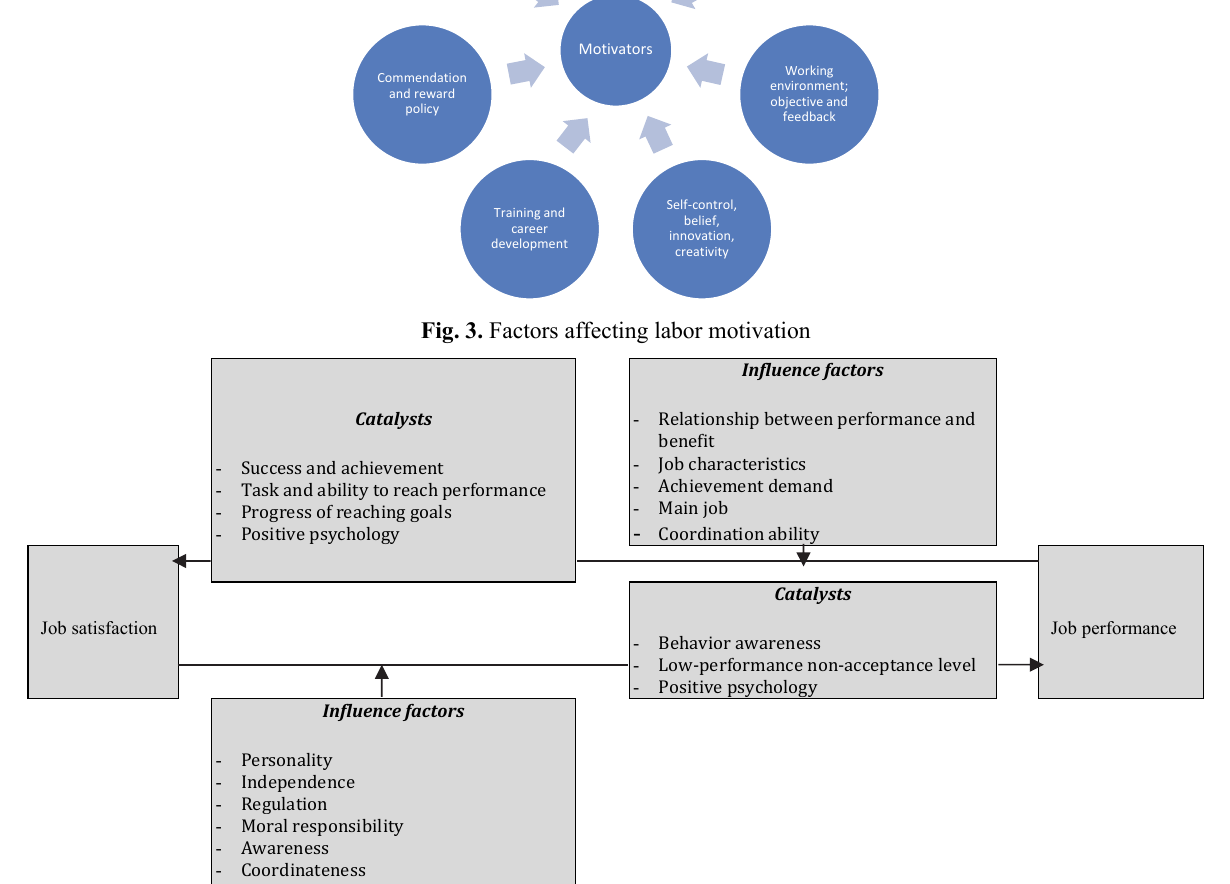
Fig. 4. Relationship between job satisfaction and job